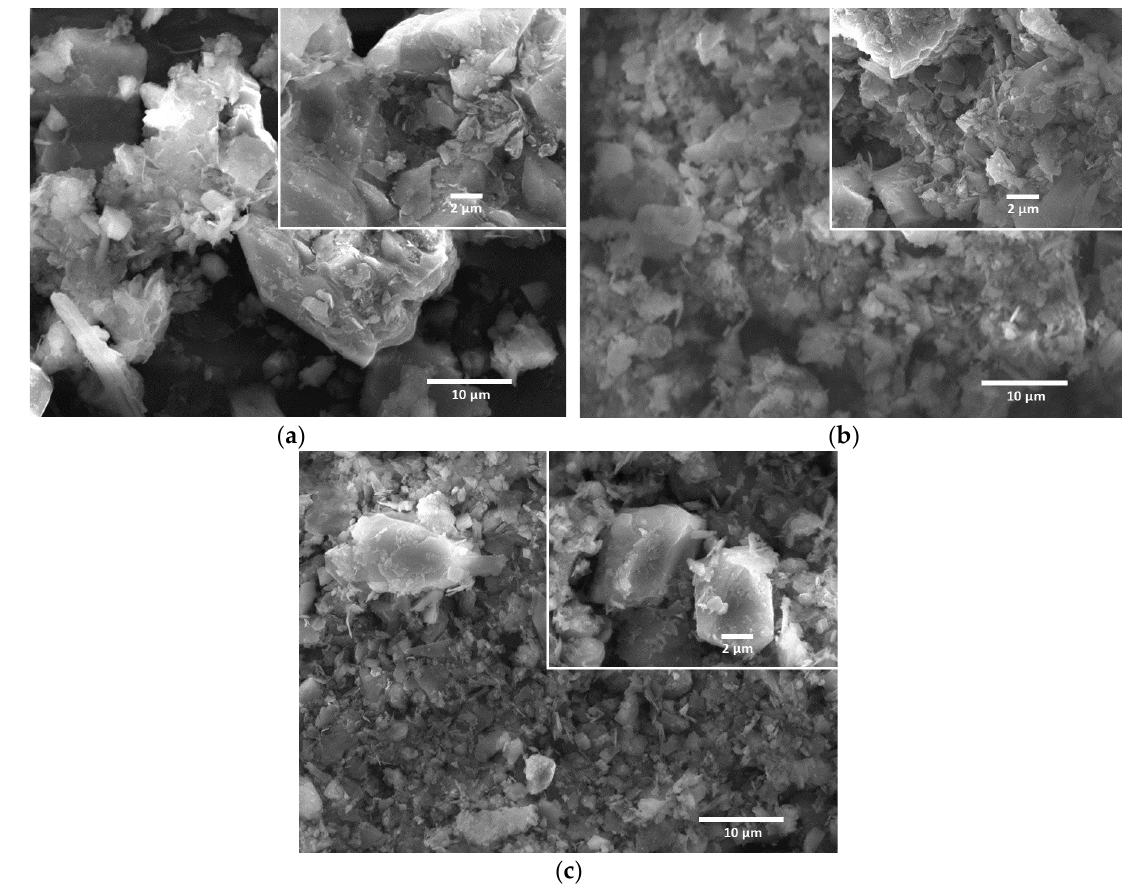
Figure 4. Scanning electron micrographs of total suspended solids obtained from ( a ) San Francisco River before confluence; ( b ) Yerba Loca Creek and ( c ) San Francisco River after confluence.